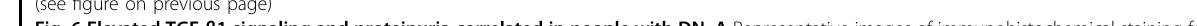
Fig. 6 Elevated TGF- β 1 signaling and proteinuria correlated in people with DN. A Representative images of immunohistochemical staining for TGF β -1 and NICD1 by DAB in the glomerulus sections from nondiabetic (ND; n = 8) and diabetic nephropathy (DN; n = 14) patients. Magni fi cation ×630. Scale bar = 20 μ m. ( n = 3). NICD1 and TGF- β 1-stained area in glomerulus (right panel) were quanti fi ed using ImageJ (NIH) and presented as a dot plot. Mean ± SD. **** p < 0.0001 by Student ’ s t test. B , C Representative image of H&E stain in glomerular sections from ND and DN groups. Black arrowhead indicates binucleated and detached podocyte. Magni fi cation ×630. Scale bar = 20 μ m. Zoomed picture emphasizes a binucleated and detached podocyte. D Representative image of MT stain in glomerular sections from ND and DN groups. Magni fi cation ×630. Scale bar = 20 μ m. MT- stained area in glomerulus was quanti fi ed using ImageJ (NIH) and presented as a dot plot. Mean ± SD. **** p < 0.0001 by Student ’ s t test. E Immunoblotting analysis for TGF- β 1 in the urine samples from ND ( n = 4) and DN groups ( n = 9). IB immunoblot. F Quanti fi cation of TGF- β 1 in the urine samples from ND ( n = 8) and DN ( n = 14) groups. Mean ± SD. ** p < 0.001 by Student ’ s t test. G Urine samples from ND ( n = 4) and DN ( n = 9) were resolved on SDS – PAGE and stained with Coomassie Blue. BSA bovine serum albumin, M protein standard marker. H Nephroseq (www. nephroseq.org) analysis comparing HES1, MIKI67, PCNA, RHOA, TGFBR1, and TP53 expression levels in ND ( n = 13) versus DN ( N = 9) in Woroniecka diabetes of glomerular tissue. Data indicate that the expression of these genes increased >1.5-fold in the DN. I Schematic illustration of GH action on podocyte cell cycle entry and apoptosis via TGF- β 1-mediated Notch1